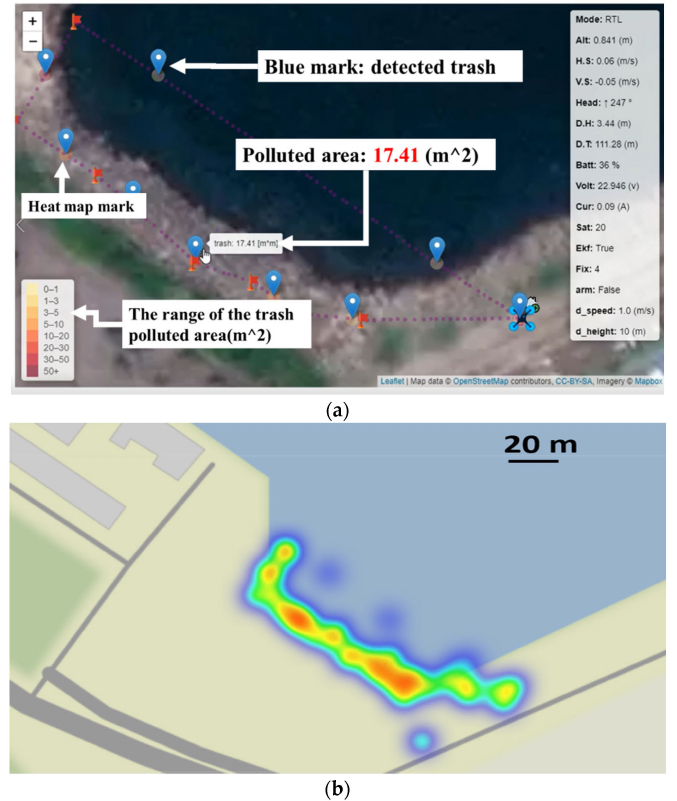
Figure 19. Trash information and heatmap with the location. ( a ) Trash polluted area with detailed trash information in the Badouzi fishing port. ( b ) The heatmap of detected trash in the Badouzi fishing